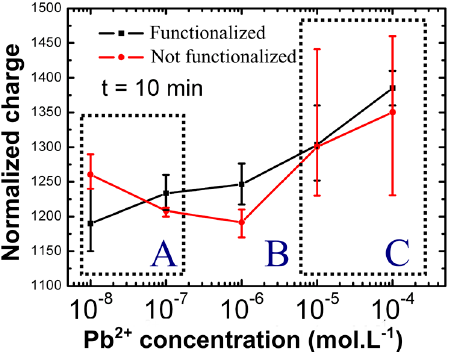
Figure 3. Normalized charge measurement for different Pb 2+ concentration after 10 min exposure. Normalized charge comparison between grafted and non-grafted poly-Si